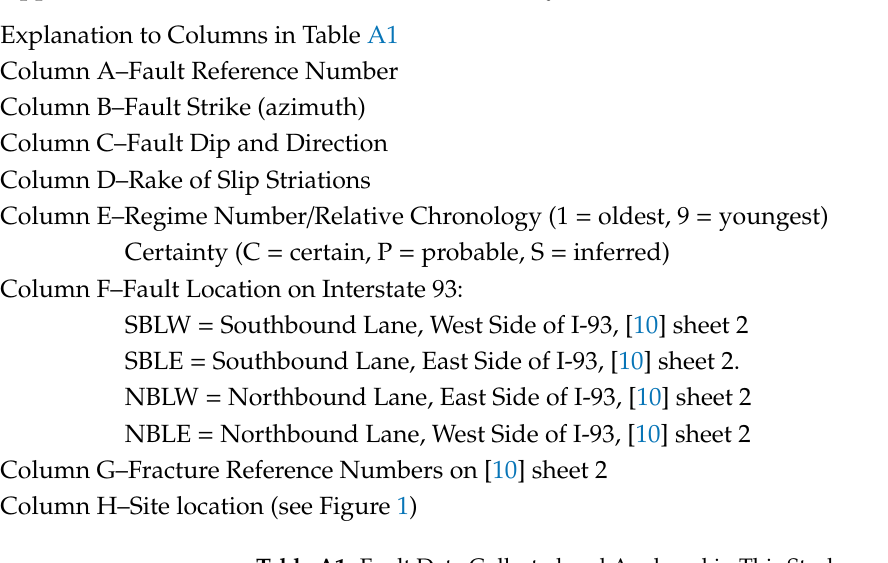
Table A1. Fault Data Collected and Analyzed in This